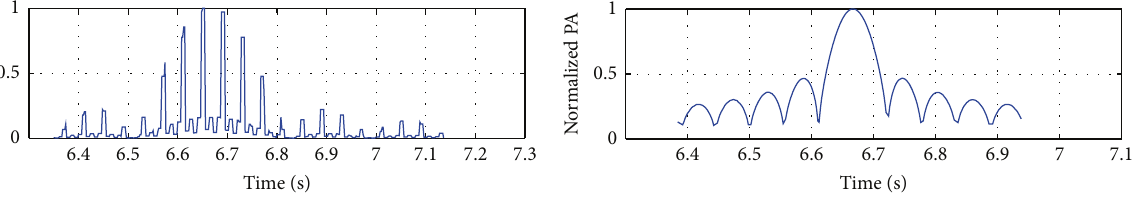
Figure 5: Beam sequence.